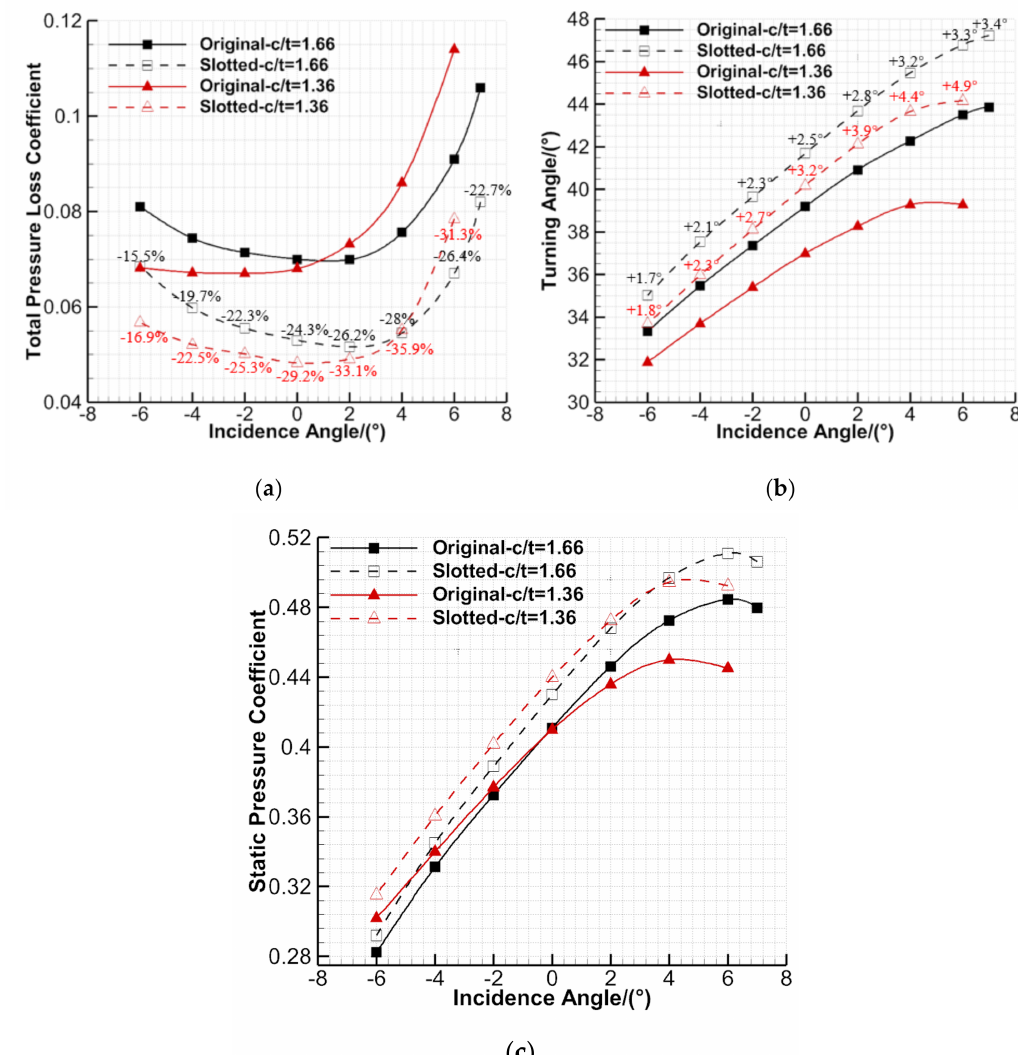
Figure 14. Aerodynamic parameters of the original cascade and combined slotted cascade in the full incidence angle range: ( a ) total pressure loss coefficient; ( b ) turning angle; ( c ) static pressure